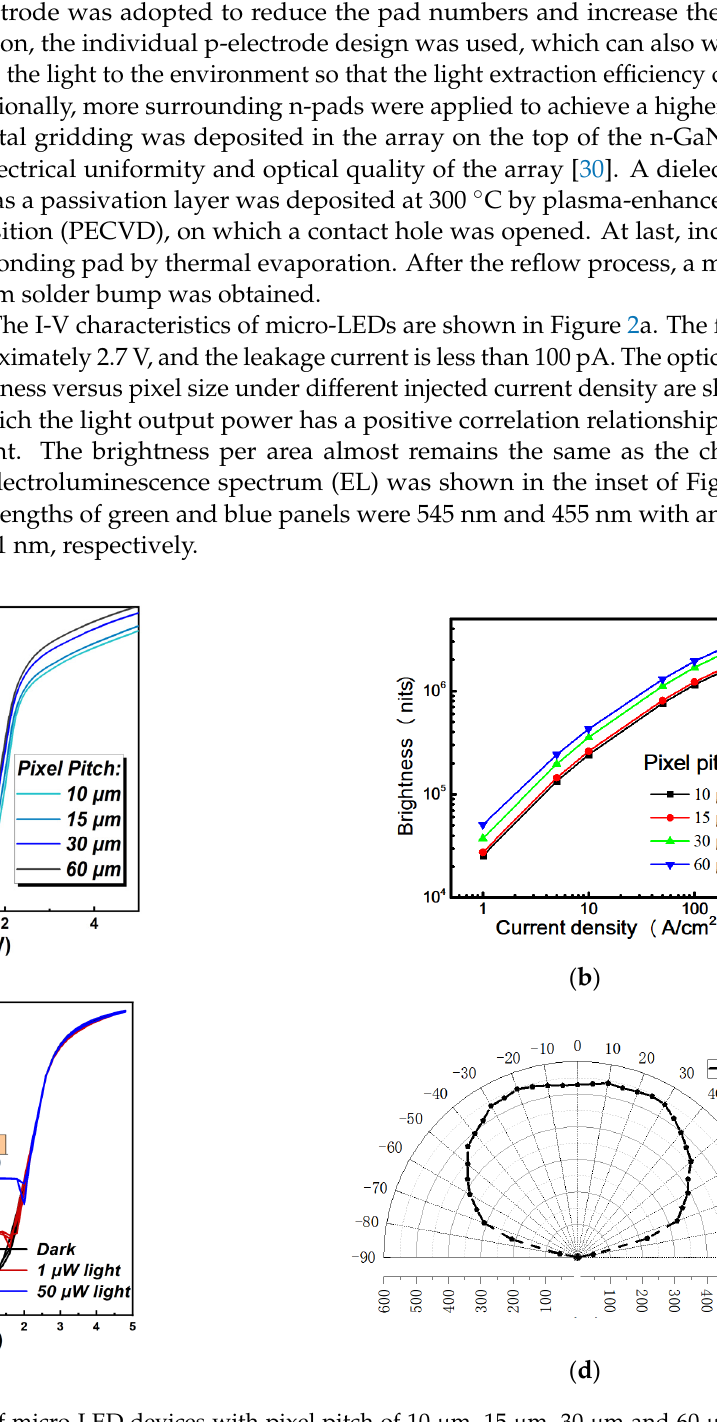
Figure 2. ( a ) I − V characteristics of micro-LED devices with pixel pitch of 10 μ m, 15 μ m, 30 μ m and 60 µ m. ( b ) optical brightness versus pixel size under different injected current density. ( c ) The ambient light effect on the devices with different illumination intensities. ( d ) Far-field luminance distribution of micro-LED displays.